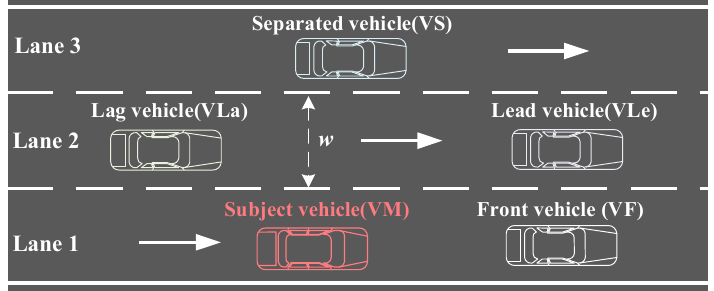
Figure 9. Multi-vehicle traffic environment.